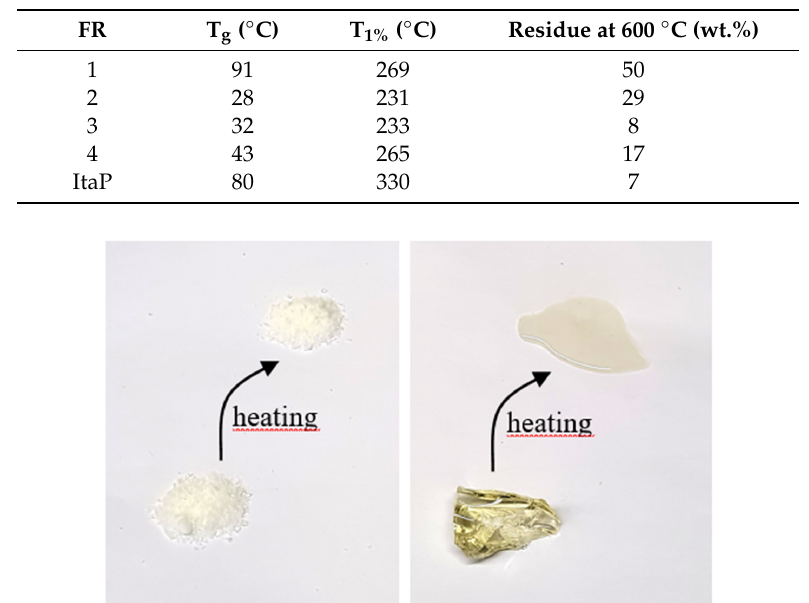
Figure 2. D ifferential scanning calorimetry (DSC) (left) and thermogravimetric analysis (TGA) (right) curves of FR 1–4 and ItaP with a heating rate of 10 K/min from 0–210 °C (DSC) and 35–600 °C (TGA) in nitrogen atmosphere.